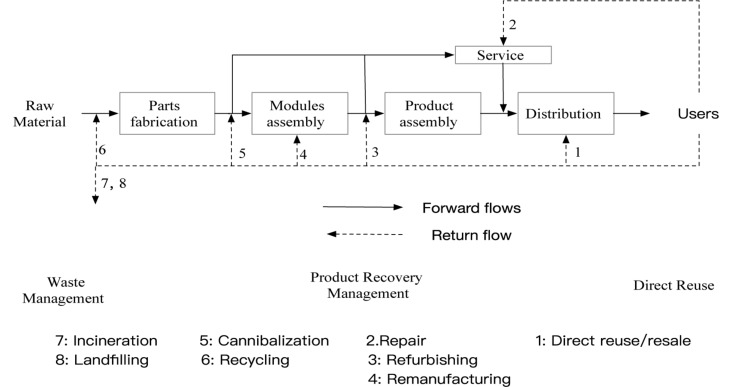
Recycling flow (Ortegon et al., 2014).